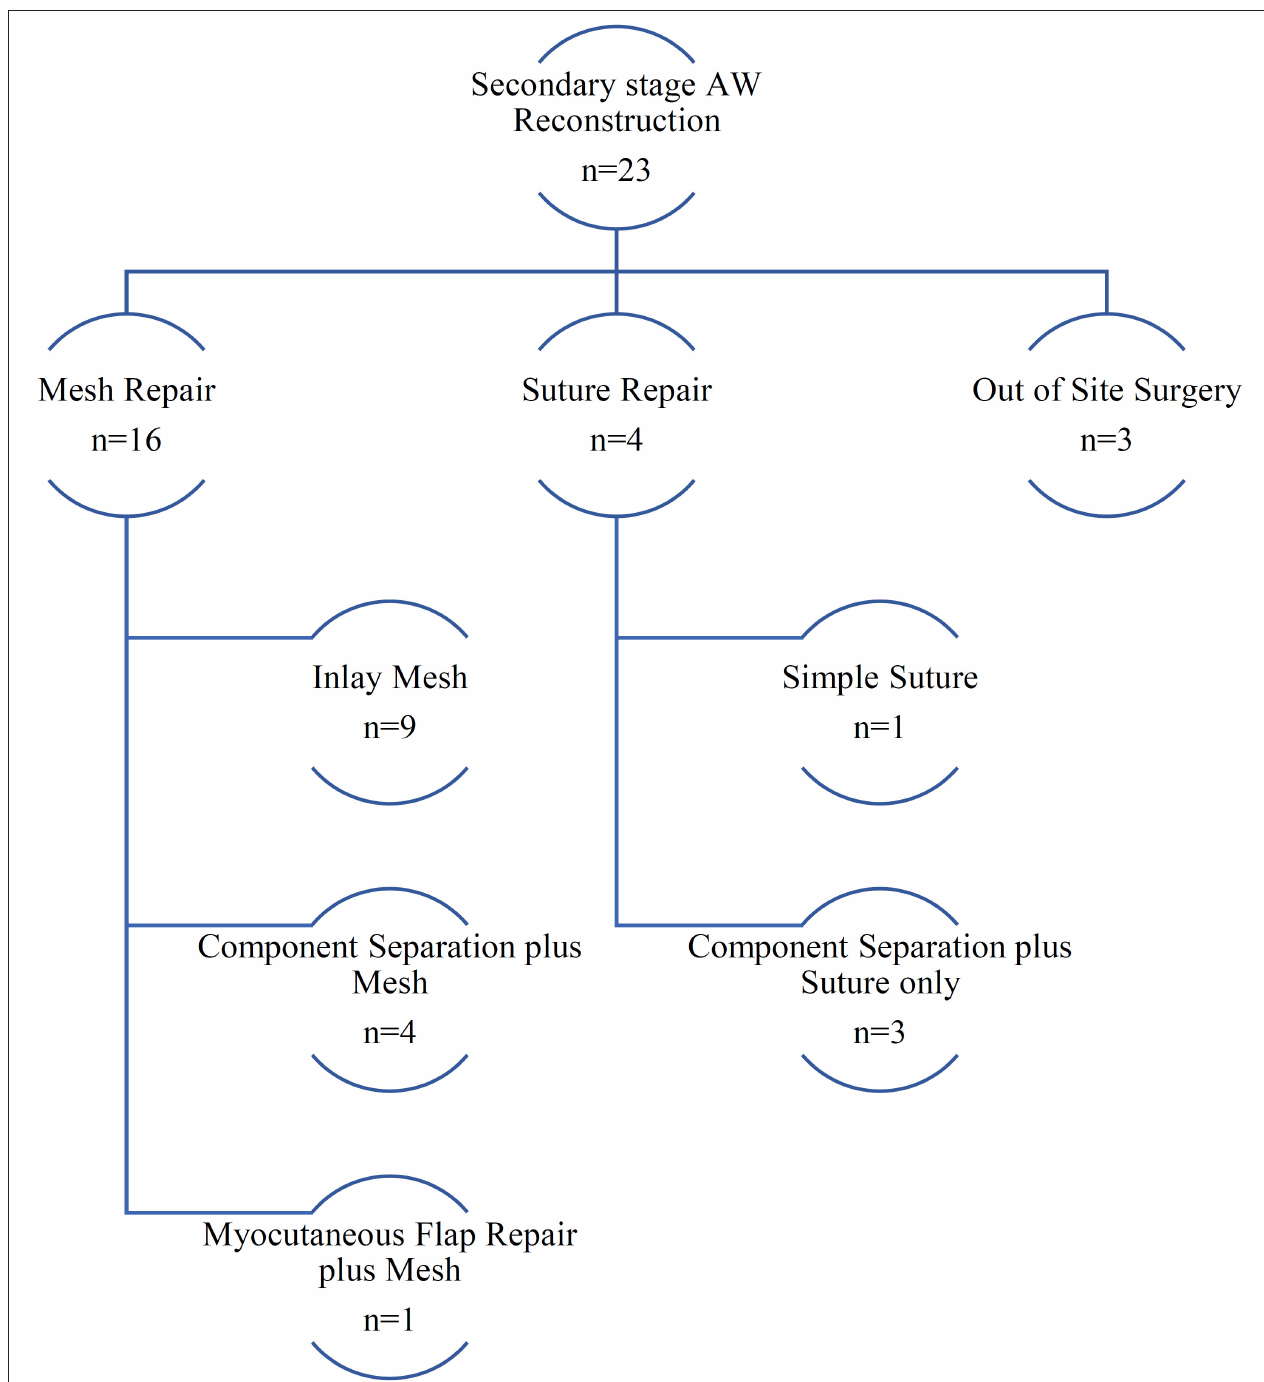
FIGURE 2 | Secondary-stage abdominal wall reconstruction techniques. The flowchart shows a synopsis of techniques used for secondary-stage abdominal wall reconstruction at our center.